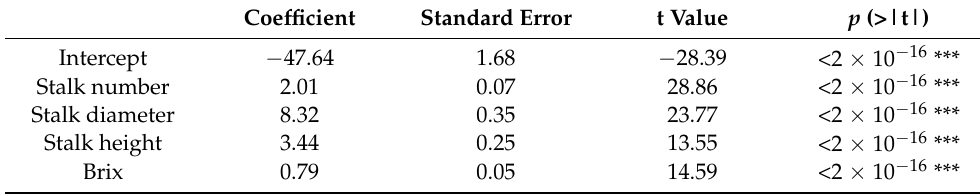
Table 5. Multivariate linear stepwise regression between sucrose yield and related